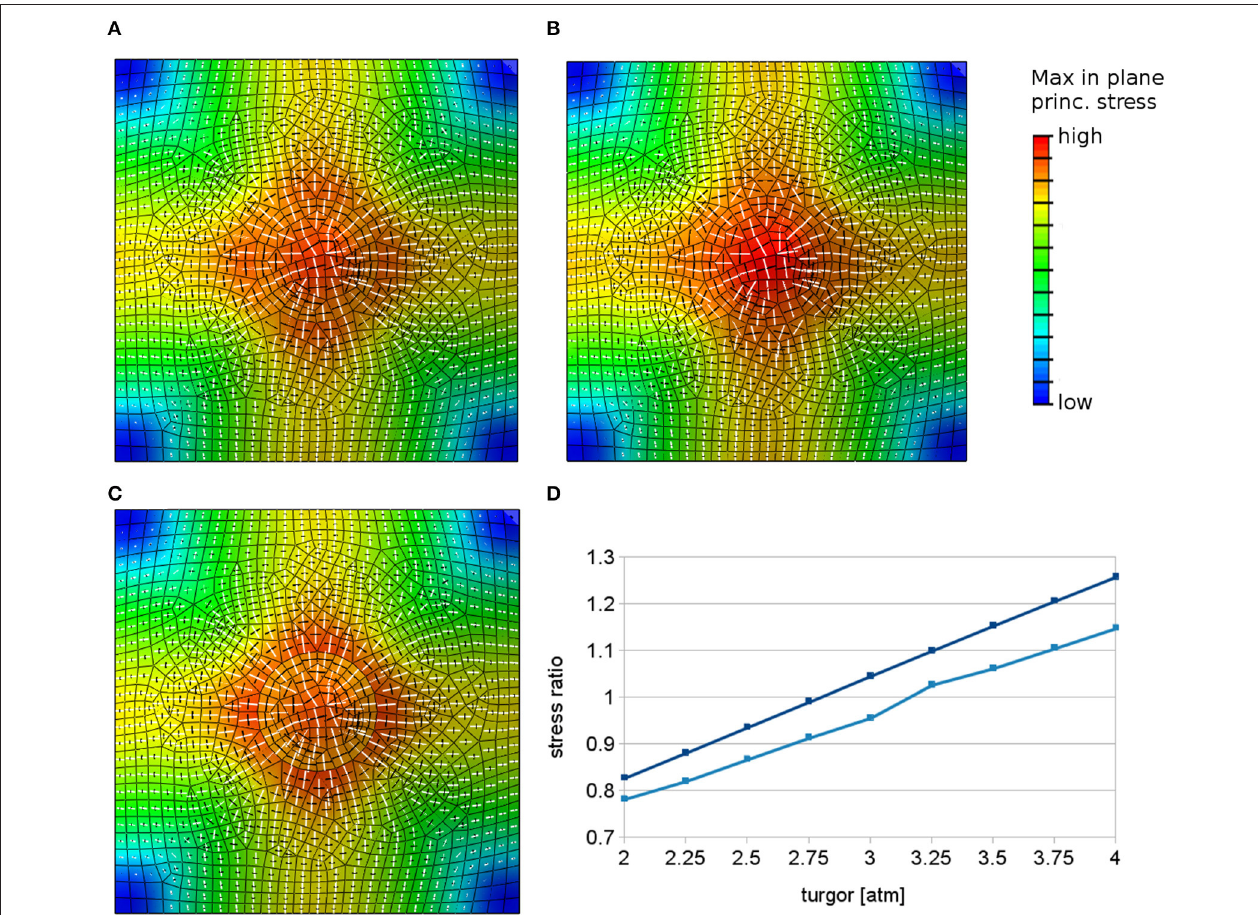
FIGURE 4 | Simulations with heterogeneous loading forces. White and black bars show respectively maximal and minimal principal stress directions in finite element models when loading forces are locally increased in the region of predicted root hair outgrowth. The color represents the maximal stress magnitude. (A) Principal stress directions predicted by finite element models in the case of locally increased pressure in the center when material properties are kept constant. (B) The radial pattern can appear also when the material in the patch is made elastically softer. (C) The mechanisms yielding radial stress alignment can be combined without destruction of the radial stress pattern. The image presents a combination of elastically stronger center with locally increased forces. The radial pattern of maximal principal stress is still evident. (D) Graph showing the trend of the stress anisotropy vs. the inner region pressure value measured at two different points on the boundary of the circular region, where the pressure is increased and the material is made softer with respect to the rest of the surface. The principal stresses change from circumferential (values below 1) to radial (values above 1).